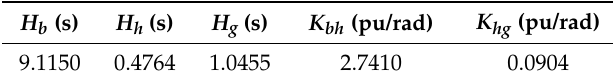
Table 1. Parameters of three-mass shaft